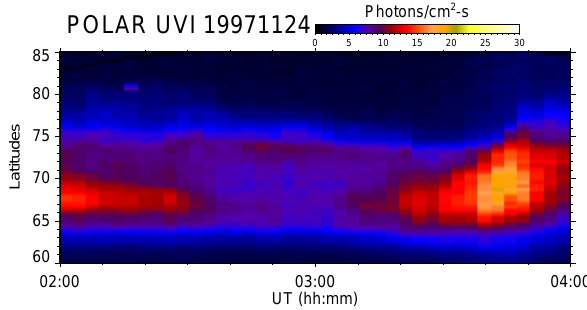
Fig. 7. A Polar UVI keogram along the ESK-FCC-GIL-ISL mag- netic meridian. The northernmost blue colours mark the polar cap